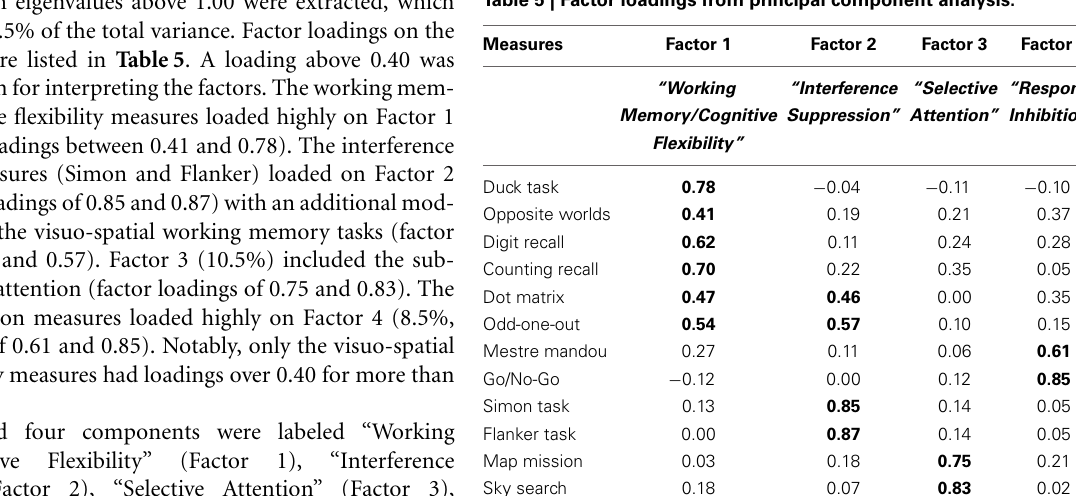
Raven CPM: Raven Colored Progressive Matrices. Upper triangle shows first-order correlations, and lower triangle shows correlations controlling for age in months. p < 0.05 are marked in boldface.